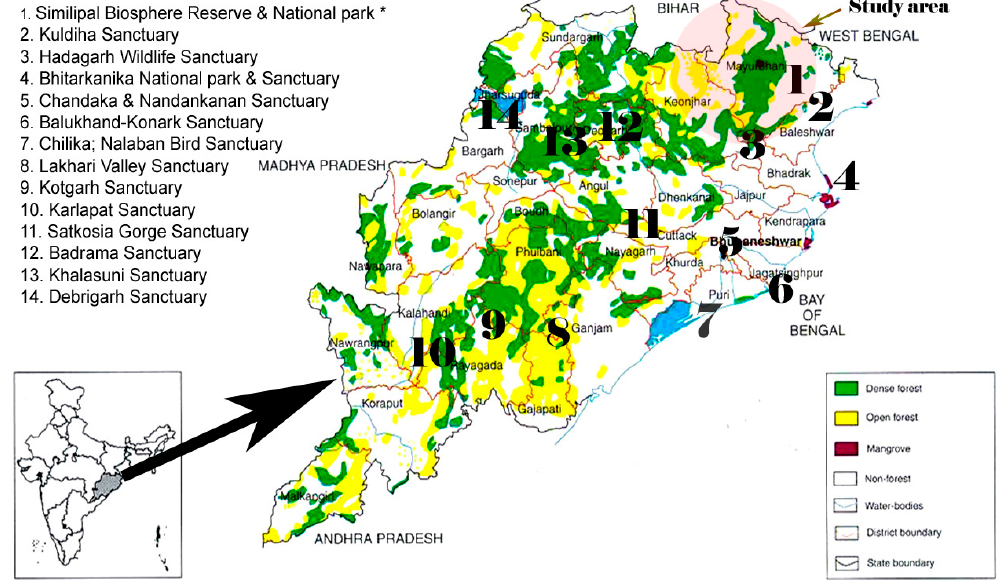
Figure 2. Forest areas of the state of Odisha showing sampling sites and biodiversity spots.